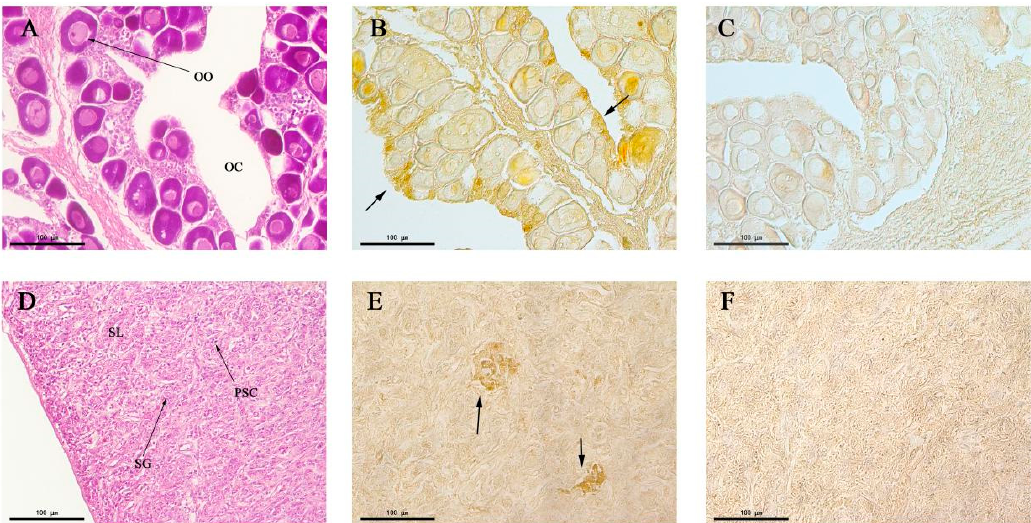
Figure 7. Localization of the CALB2 protein in the testis and ovary of P. olivaceus detected by immunohistochemistry. ( A ) Ovarian tissue section with Hematoxylin and Eosin (HE) staining; ( B ) CALB2 immunoreactivity in the ovary; ( C ) negative control of B; ( D ) testis tissue section with HE staining; ( E ) the CALB2 immunoreactivity in the testis; ( F ) negative control of E. OO, oocytes; OC, ovarian cavity; SG, spermatogonium; SL, seminal lobule; PSC, primary spermatocyte.